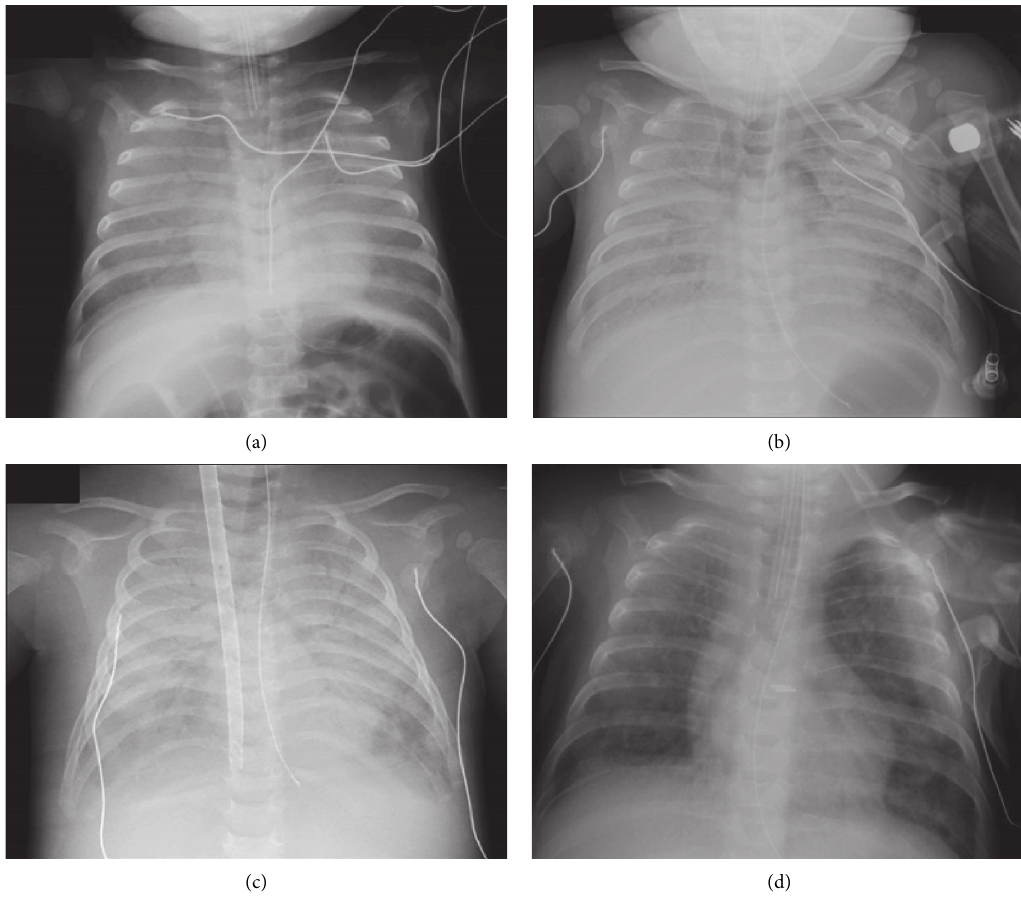
Figure 2: Chest X-rays taken on admission (a): on the day before cannulation and VV-ECMO commencement (b), on the day of VV-ECMO commencement (c), and on the day before extubation (d). Note the Avalon Cannula projecting in front of the superior and inferior vena cava in